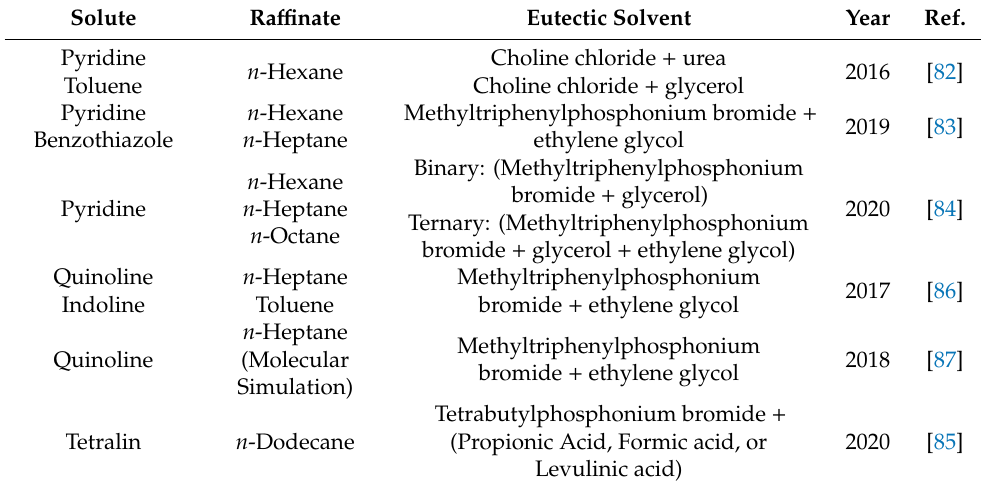
Table 4. Eutectic Solvents in the Extraction of Nitro-Containing Aromatic Hydrocarbons and Polycyclic Aromatic